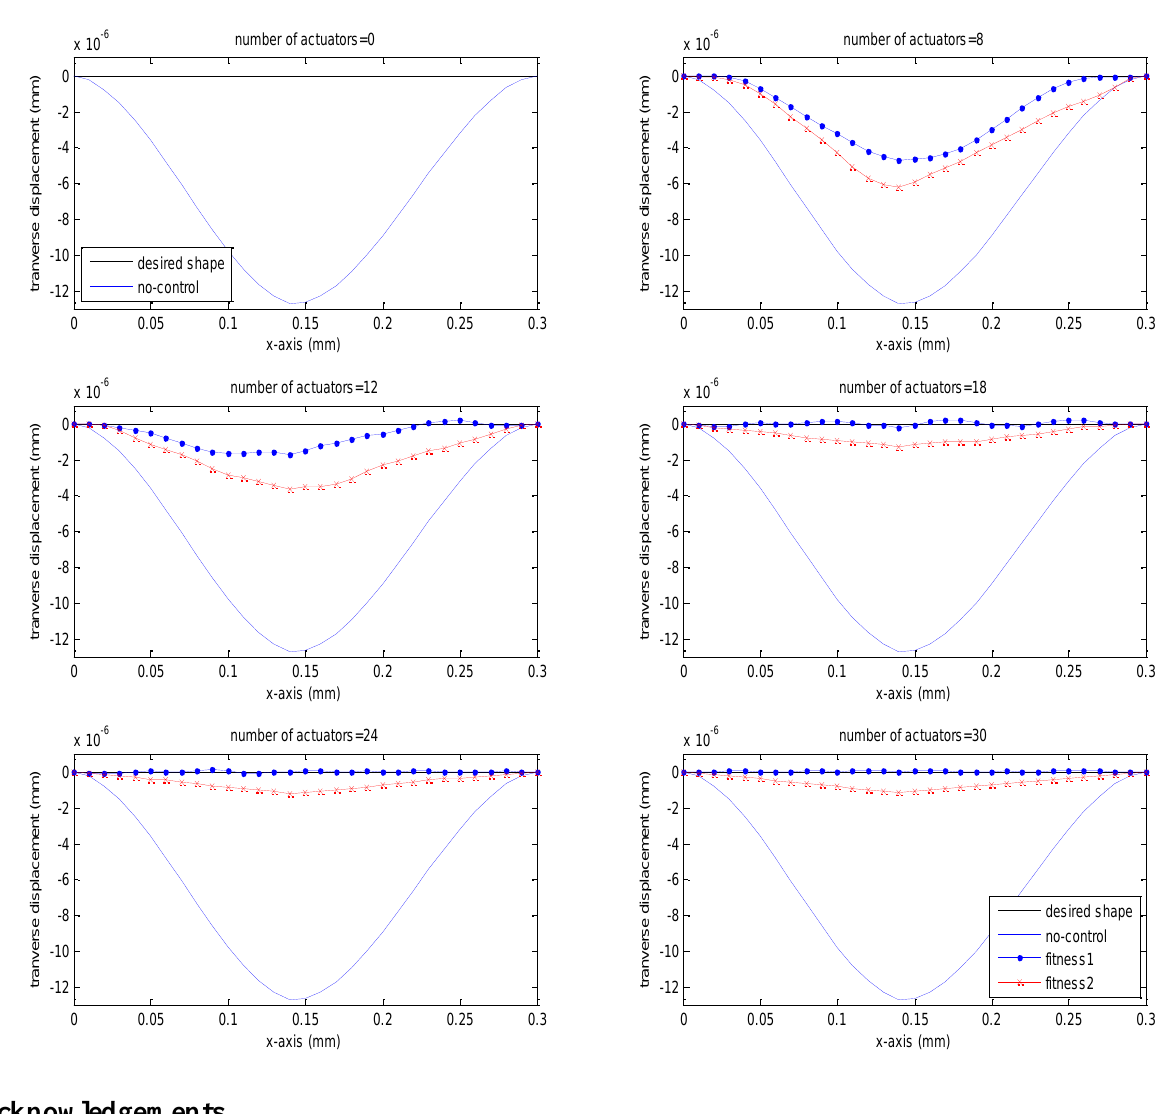
Figure 4. The centerline of the clamped−clamped smart beam under the action of various numbers of actuators for X d (x) = 0 with the optimal values of actuation